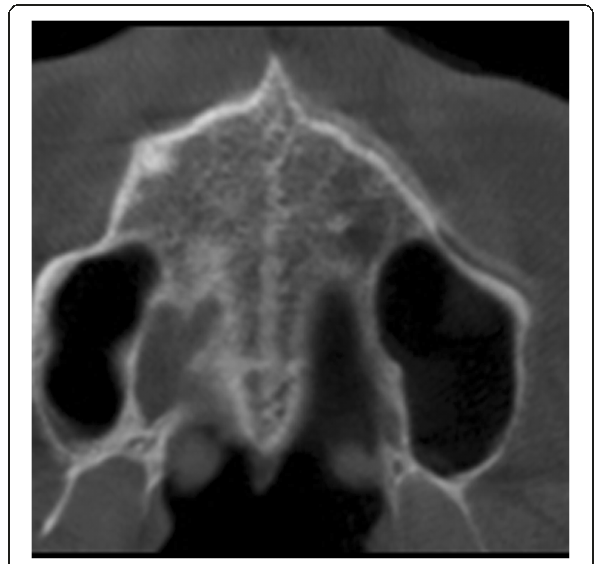
Fig. 3 Example of the midpalatal suture condition in a patient of 25- year-old boy in stage B appears as a scalloped high-density